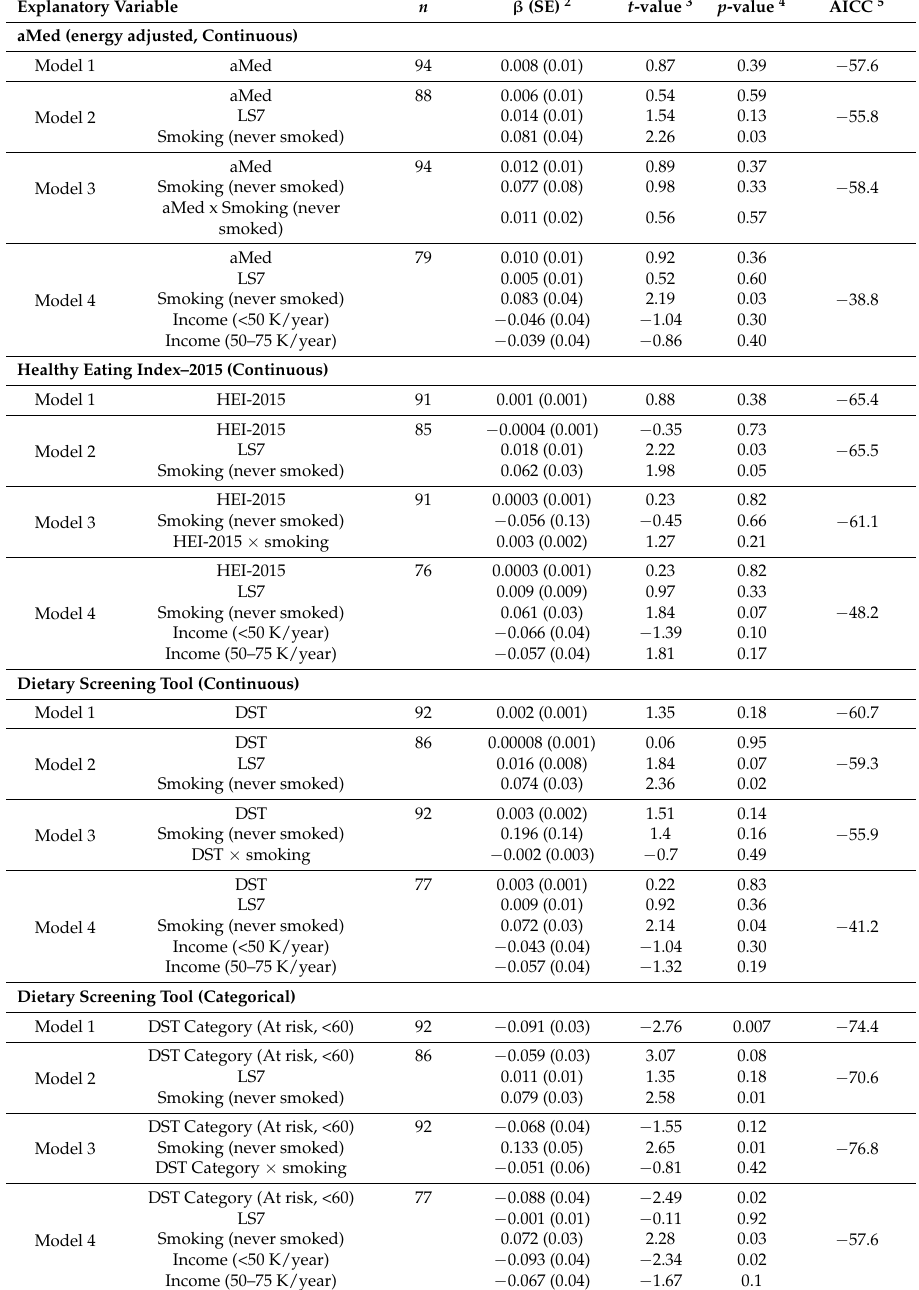
1 Models of fitting rLTL (continuous) from unadjusted diet quality scores (Model 1, simple linear regression), after adjustment to LS7 and smoking history (Model 2), after adjustment to interaction of diet quality and smoking (Model 3), and after additional adjustment for income (Model 4). Models 2-4 are multivariate covariance models with combination of continuous (aMed, HEI-2015, DST, LS7) and categorical (smoking and Income) explanatory variables using PROC MIXED of SAS Ò . 2 Parameter estimates ( β = slope) and standard error (SE) of the estimate of the factor in the model. 3 t -value tests the null hypothesis β = 0 meaning that the parameter (slope) is zero, thus that model component does not affect the rLTL. 4 Significant p -value <0.05. 5 AICC, Akaike Information Criterion with Correction for small sample size is a criterion of goodness of fit of the model; smallest AICC is considered an optimal model. The overall optimal model (AICC = − 76.8) is based on categorical DST with adjustment to smoking in addition to DST and smoking interaction. Abbreviations: aMed, alternate Mediterranean Diet; LS7, Life’s Simple 7; HEI-2015, Healthy Eating Index 2015; DST, Dietary Screening